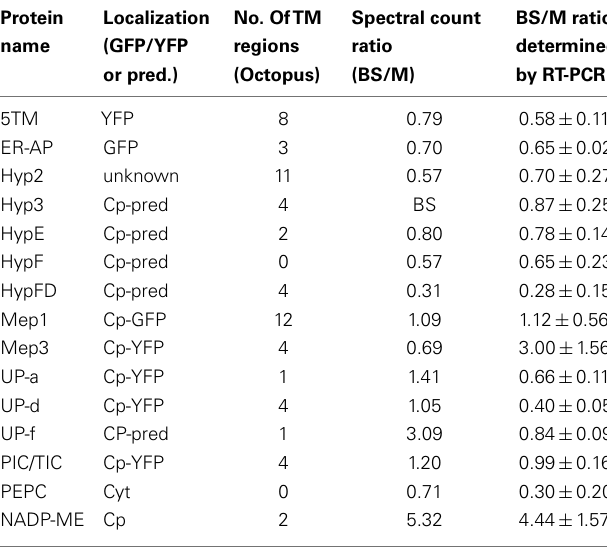
BS versus M localization based on RNA-Seq data and compared those to a proteomics data set (Friso et al., 2010). They assigned ER-AP, UP-d, and PEPC to the mesophyll, while Mep1, Mep3,